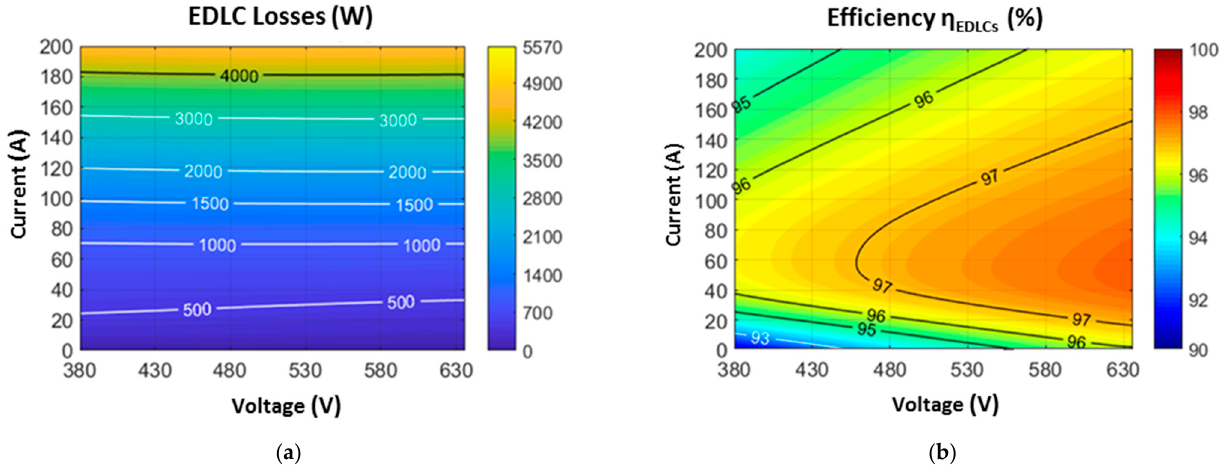
Figure 9. ( a ) Total losses map in the energy storage system (ESS) (sum of all commented power losses) as a function of current and voltage and ( b ) total efficiency map of the SC cabinet as a function of current and voltage.